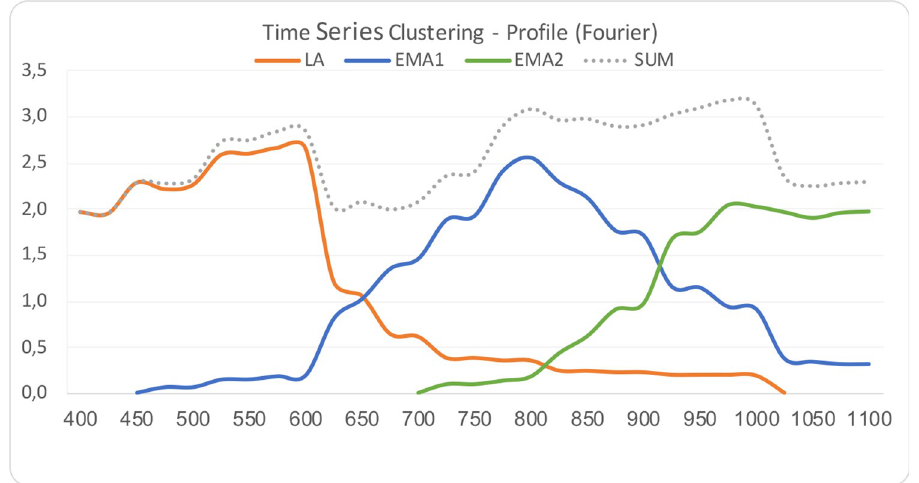
Fig 3. Archaeological periodization with time series clustering: LA—Period 1, Late Antiquity; EMA1—Period 2, Early Middle Ages 1; EMA2—Period 3, Early Middle Ages 2. Values on x axis are years CE, values on y axis are unitless and